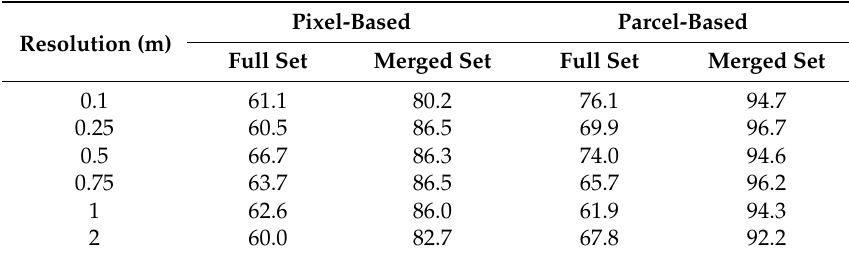
Table 4. Overall accuracy (OA (%)) for 5SE-RGB for all tested spatial supports (i.e., pixel- and parcel-based) and crop classes at different spatial resolutions.